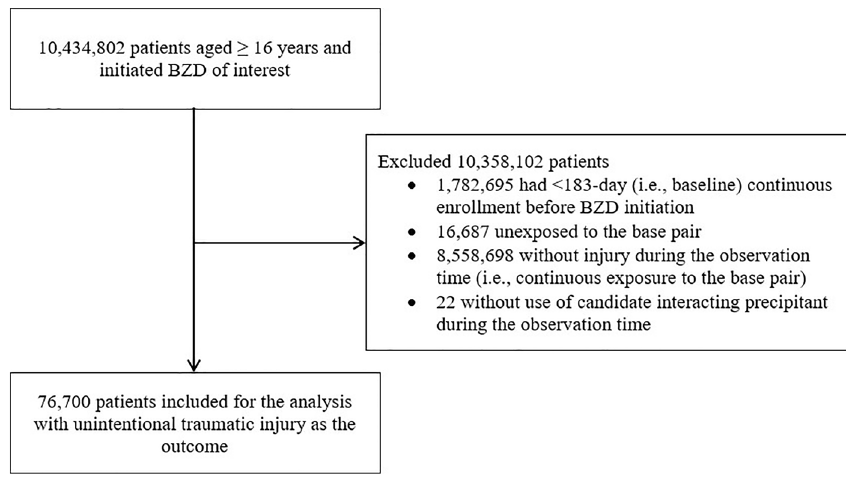
Figure 2. Flowchart of sample selection for the analysis for unintentional traumatic injury. BZD, benzodiazepine and related drug.